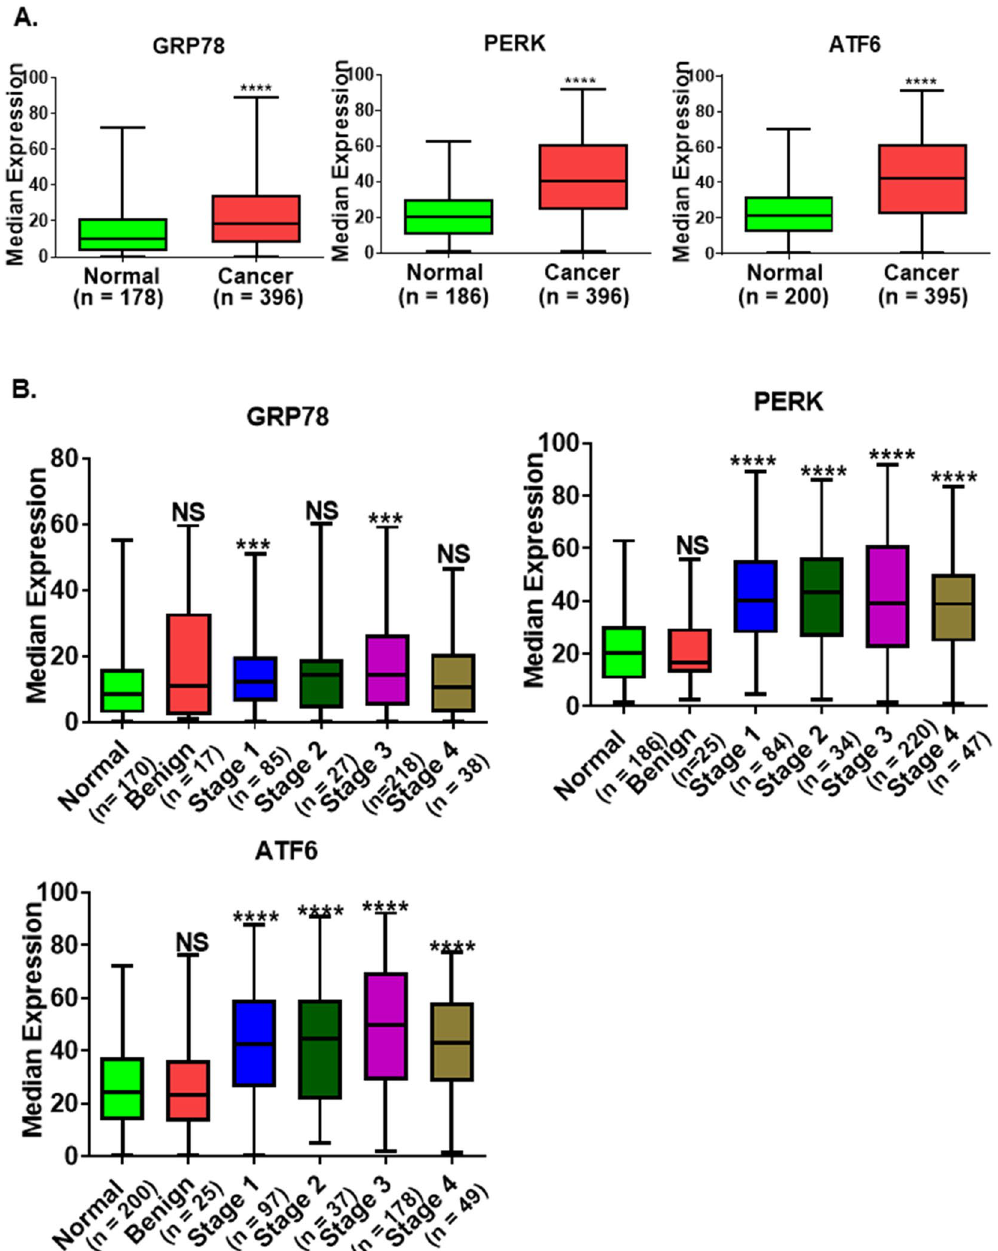
Figure 3. Expression of ER stress-associated proteins in ovarian cancer. ( A ) GRP78, PERK, and ATF6 are highly expressed in ovarian cancer compared to normal tissues. ( B ) Expression of ER stress-associated proteins in normal, benign and malignant tumor tissues collected from ovarian cancer patients with different stages, two US patient populations (USC and UM) and a Japanese patient population (KCCRI). p -values were calculated by the non-parametric Mann-Whitney U test in GraphPadPrism 8.1.0. **** p -value < 0.0001, *** p -value <